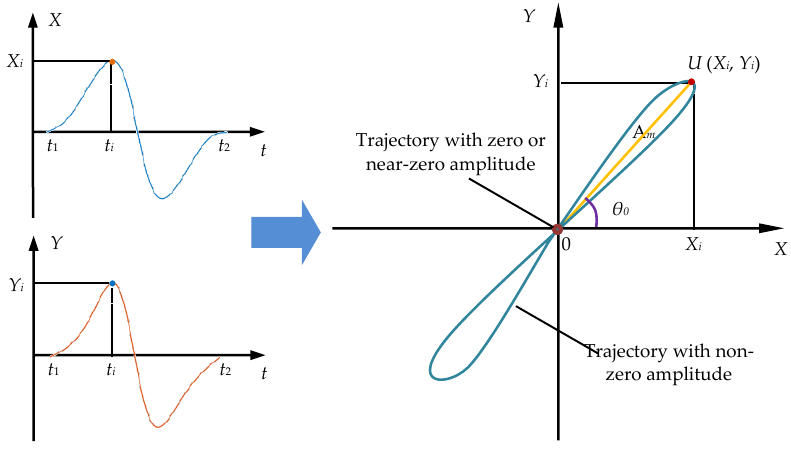
Figure 4. Schematic diagram of the amplitude–phase trajectory of the balanced-field electromag- netic technique.